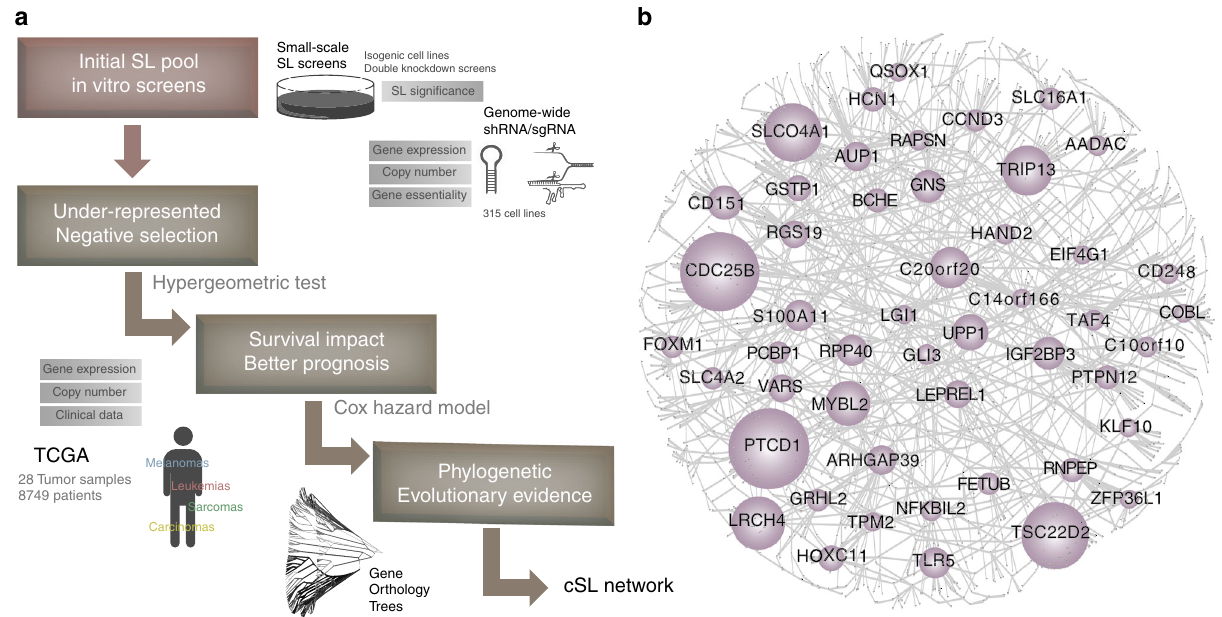
Fig. 1 ISLE framework and the clinical-SL-network. a The three step inference procedure of ISLE and the datasets used in each step (Methods). b The core clinical-SL-network (with FDR < 0.1) includes 2326 interactions between 2153 genes, where the gene names having more than 10 cSL partners are marked; the size of nodes is proportional to the number of interactions they have). The complete network with FDR < 0.2 (the correction level used in all analyses presented in the paper) is provided in Supplementary Fig. 1 and in an interactive form at GitHub: